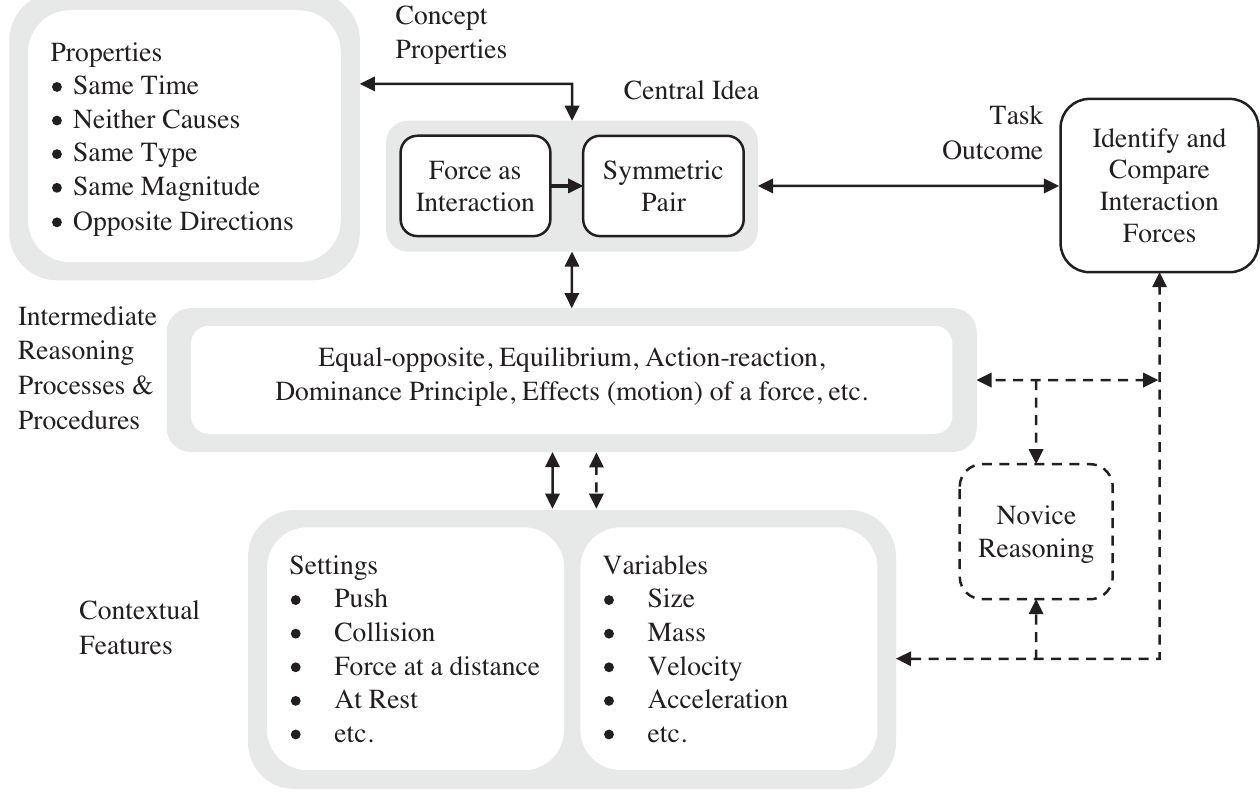
FIG. 1. Conceptual framework for Newton ’ s third law. Solid arrows represent experts ’ conceptual pathways while dashed-line arrows represent novices ’